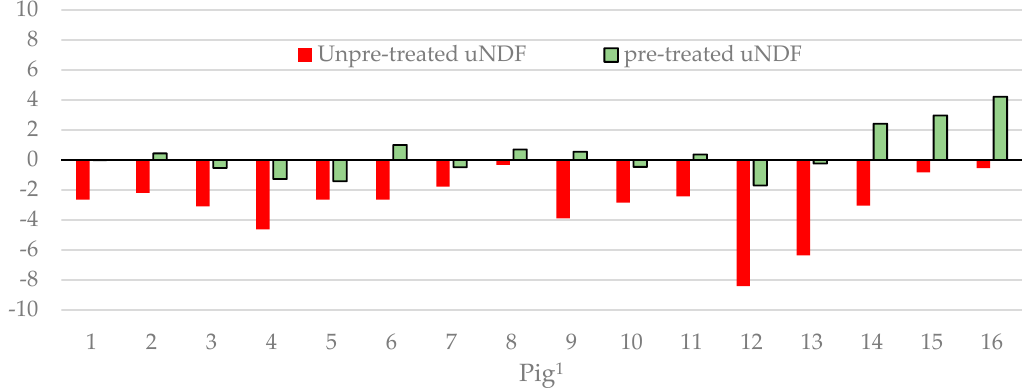
Figure 1. Differences in Organic Matter digestibility (percentage units) between the values predicted by the uNDF method (unpre-treated or pre-treated) and those determined by total faecal collection method for the 16 pigs. 1 Pig: from 1 to 8, pigs fed the conventional diet; from 9 to 16, pigs fed the low-protein diet.